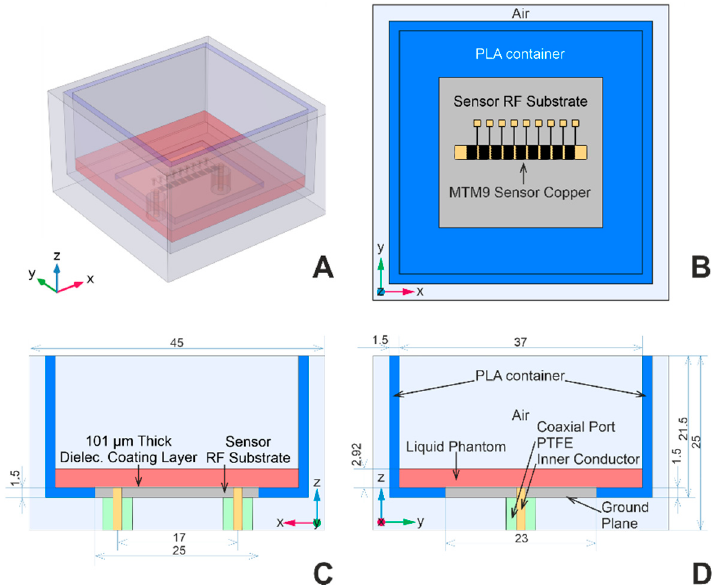
Figure 3. Computational domain geometry; ( A ) and ( B ) are perspective and top view of the computational domain geometry, respectively. ( C ) and ( D ) are detailed views of the cross-sections in xz and yz planes with dimensions in mm. Table 2. Dielectric parameters of individual domains of the computational area and the maximum recommended and used edge length of the discretization elements.